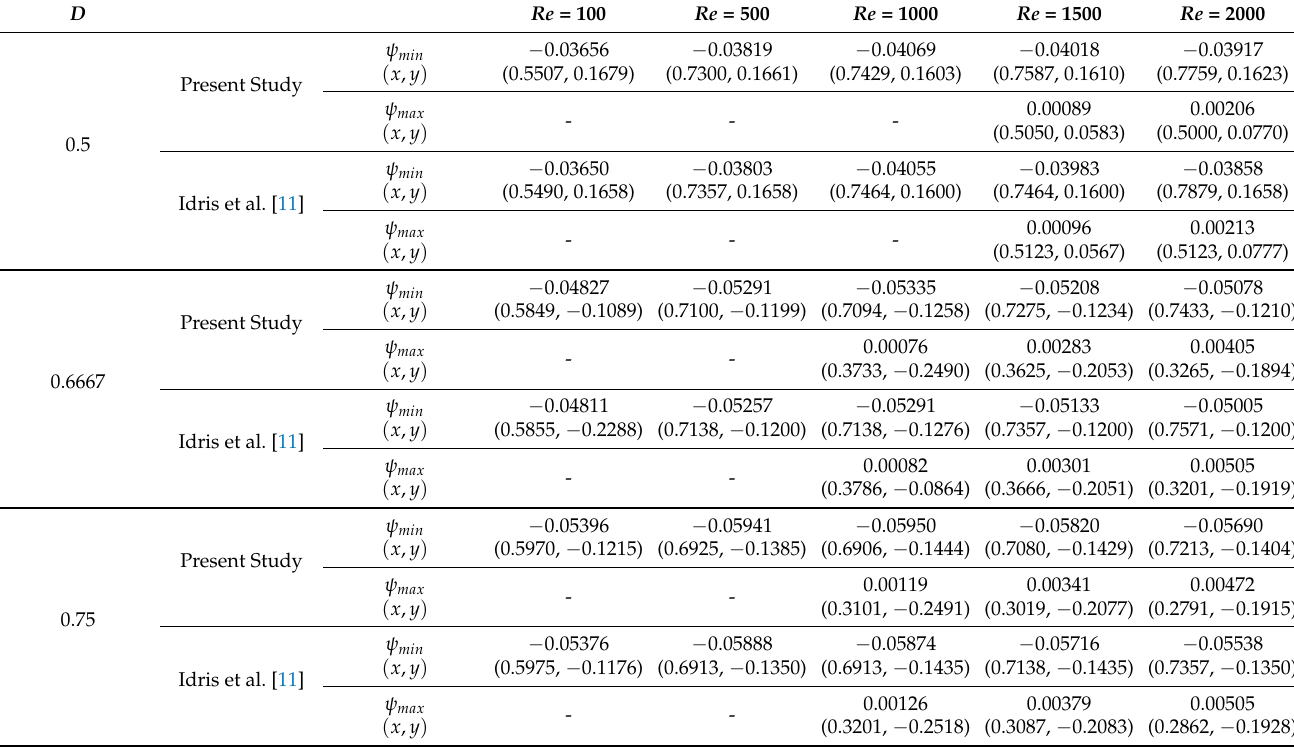
Table 1. Comparison of flow properties for D = 0.5, 0.6667 and 0.75 aspect ratio